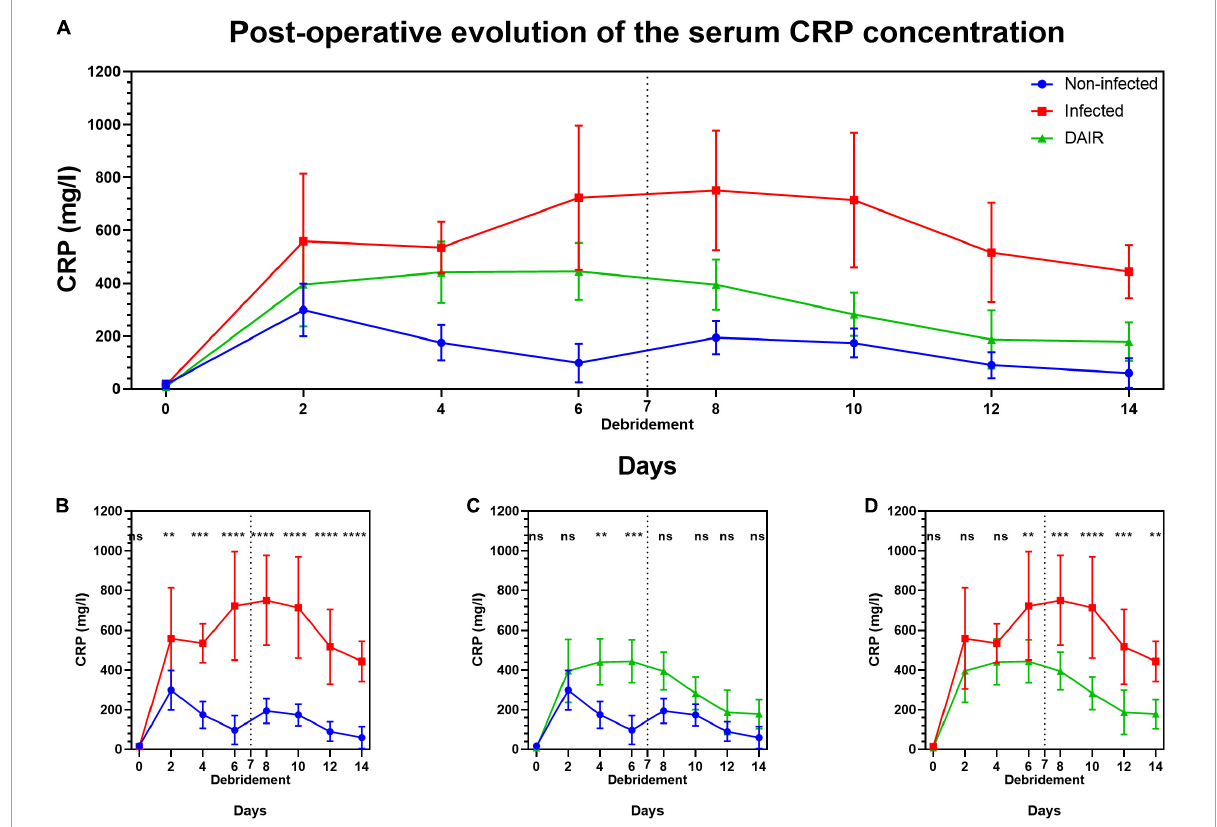
FIGURE5 Post-operative evolution of the serum C-reactive protein (mg/l) in groups A, B, and C (A) and comparisons between groups A and B (B) , A and C (C) , B and C (D) . Vertical dashed lines indicate the day of debridement surgery. Statistical analysis: two-way repeated-measures ANOVA and Tukey HSD post hoc test. ns p > 0.05; * p < 0.05; ** p < 0.01; *** p < 0.001; **** p < 0.0001. N =